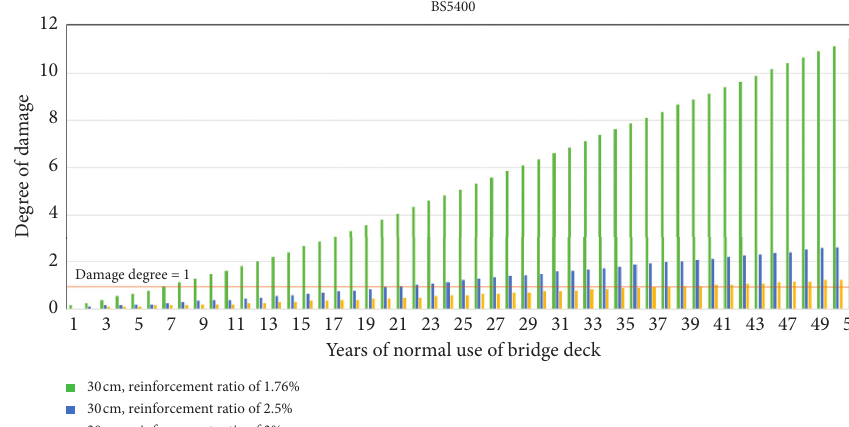
Figure 19: Fatigue damage of bridge-deck reinforcement under three reinforcement ratios with a slab thickness of 30cm.